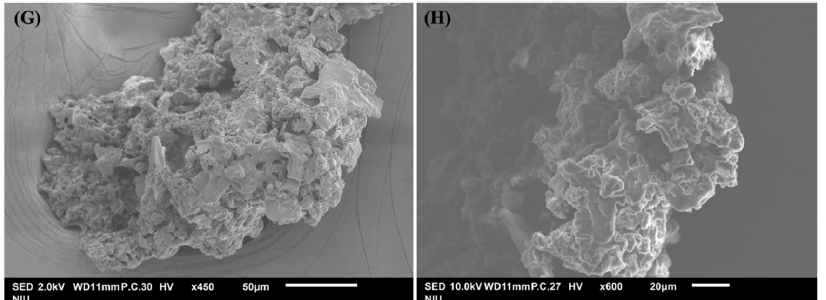
Figure 1. ( A ) Schematic diagram showing the synthesis of IC ( B ) Co-evaporation of ethanolic extract of AC (brown) and BCD (white) resulted in the formation of the IC (yellow). ( C ) Water solubility analysis of BCD, AC, and IC. ( D ) Water solubility analysis of different concentrations of IC. Morphological analysis of ( E ) BCD, ( F ) AC ( G ), and ( H ) IC using